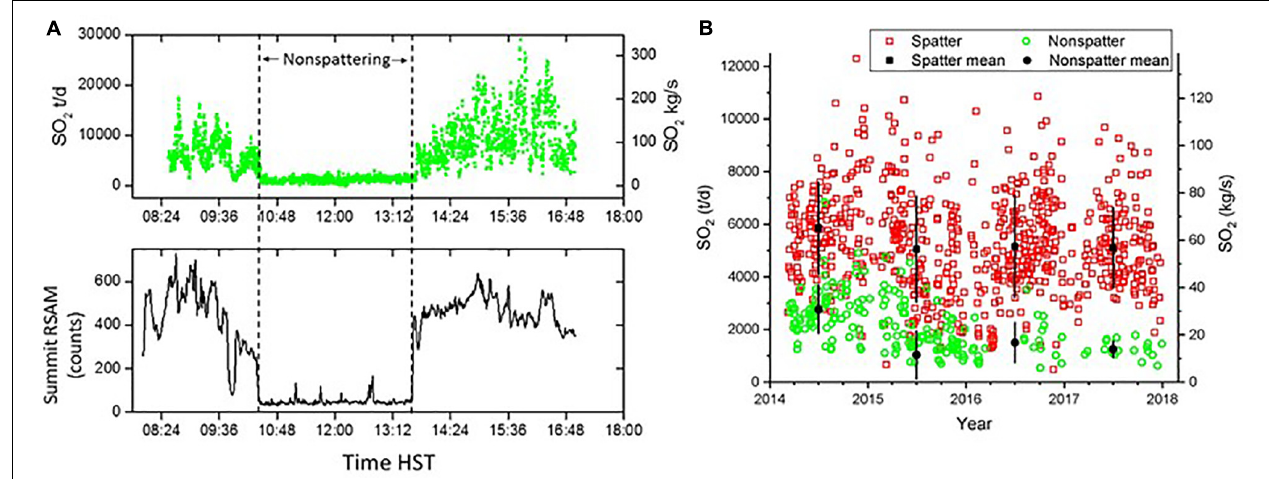
FIGURE 6 | (A) SO 2 emission rates (green) and relative seismic amplitude (RSAM, frequency > 0.2 Hz, black) during a transition between spattering and non-spattering lava lake conditions (marked by dashed lines) at K¯ılauea Overlook vent on 9/9/2016. (B) Daily average SO 2 emissions for lava lake spattering (red) and non-spattering (green) periods lasting > 1 h for 2014–2017. Non-spattering episodes are defined by RSAM level < 100 counts. Annual mean and standard deviation are shown by black symbols for spattering (square) and non-spattering (circle) episodes. The sparser data at the beginning of each year reflects the seasonal nature of the trade winds. A lack of trade winds during the winter months results in fewer measurable plume